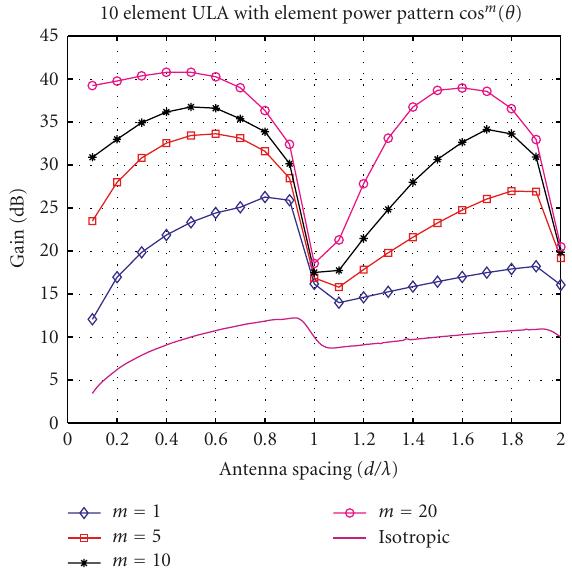
Figure 5: The antenna array gain as a function of antenna spacing for 10 elements ULA with di ff erent element